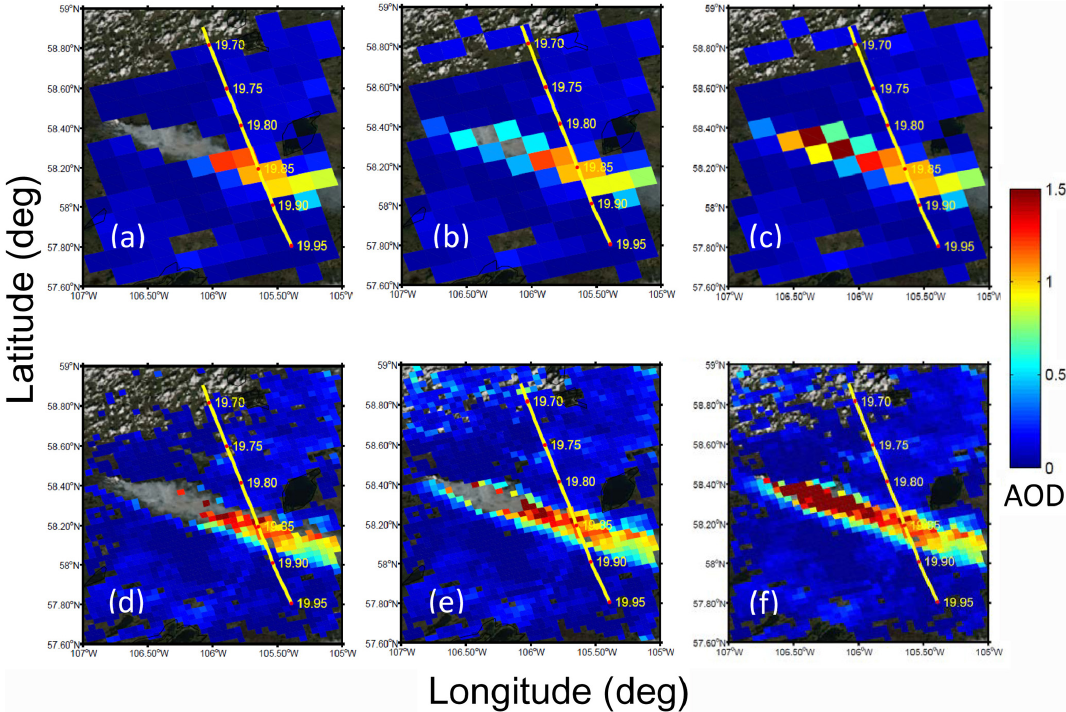
Fig. 2. Overlay of P-3 flight track and color-coded MODIS AOD retrievals at 553nm at 10km (a–c) and 3km (d–f) resolution on RGB image for the 19.85UT overpass on 30 June 2008. Results for MODIS C006 (a, d) operational retrieval, (b, e) retrieval with aerosol cloud mask off, and (c, f) retrieval with both aerosol cloud mask and NDVI mask